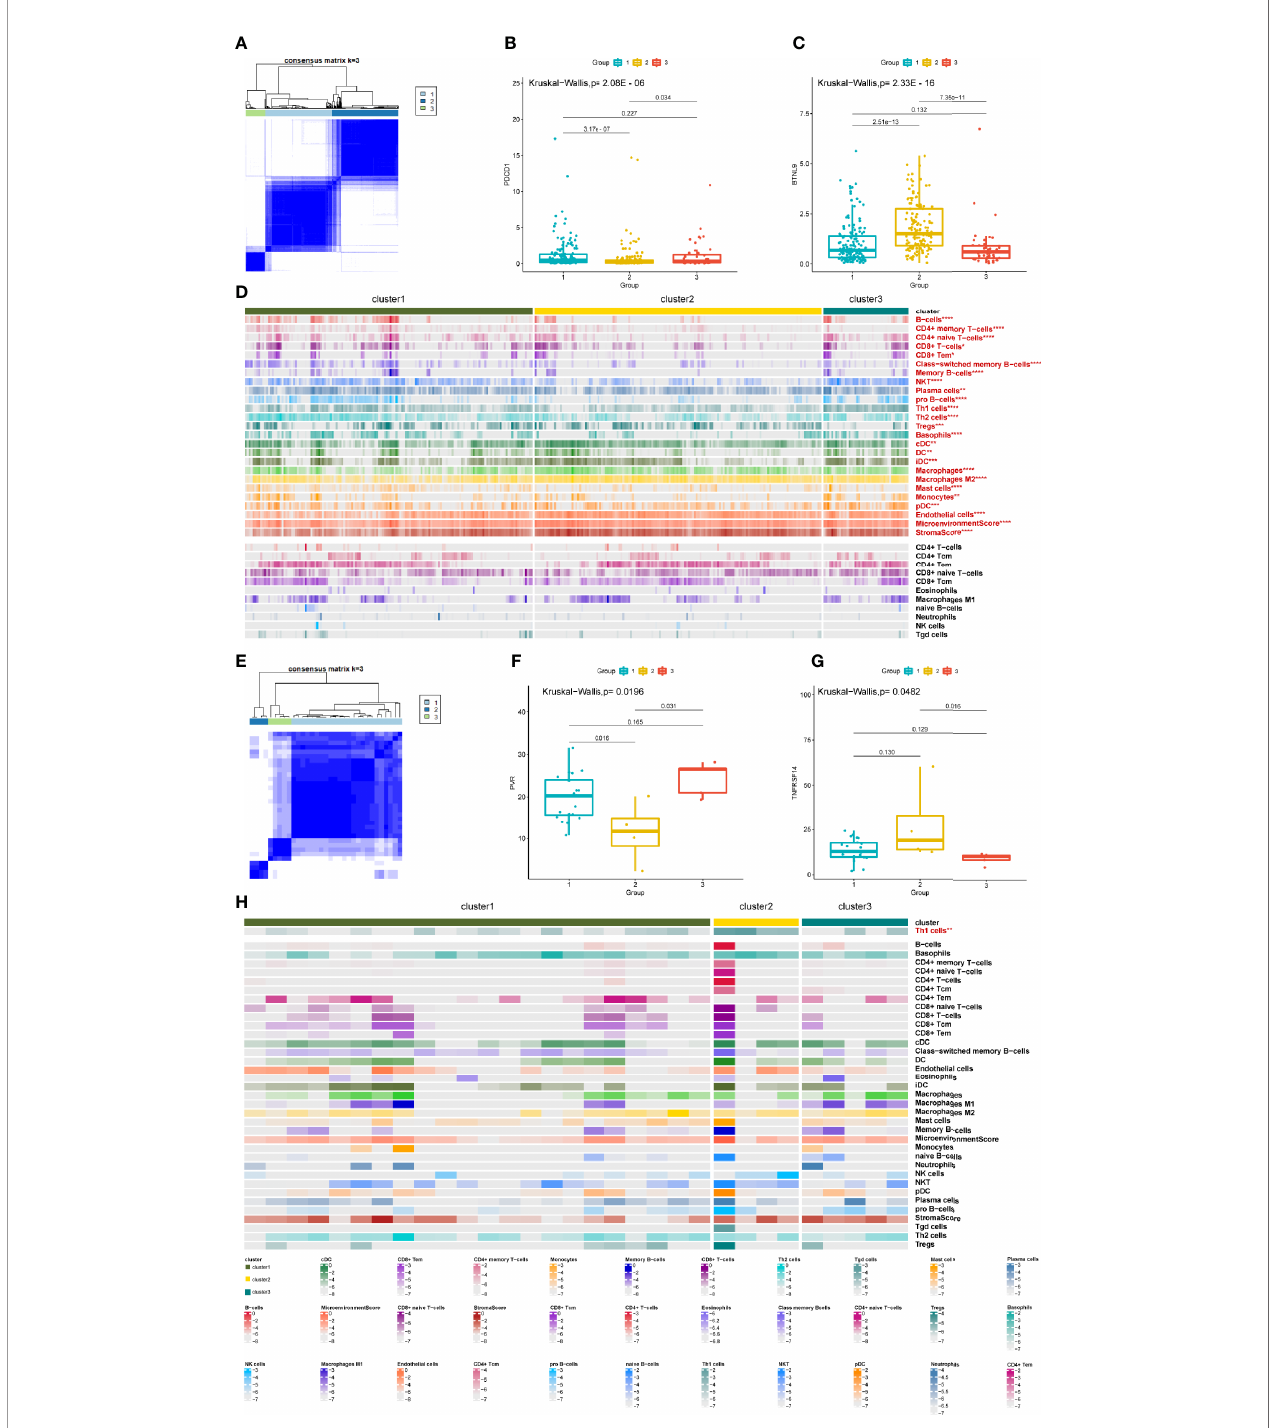
FIGURE 4 | DEAS clusters correlated with immune features in HCC and ICC. (A) Consensus matrix heatmap of HCC. (B, C) The compassion of two representative immune checkpoints in three clusters. (D) Heatmap of the DEAS events in HCC ordered by clusters. (E) Consensus matrix heatmap of ICC. (F, G) The compassion of two representative immune checkpoints in three clusters. (H) Heatmap of the DEAS events in ICC ordered by clusters, with annotations related with each cluster. *P < 0.05, **P < 0.01, ***P < 0.001, ****P <